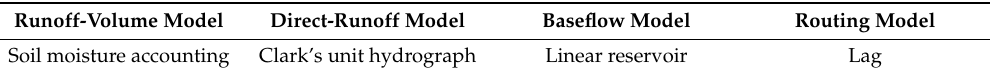
Table 2. Hydrologic Engineering Center Hydrologic Modeling System (HEC-HMS) simulation scheme of Xinxie